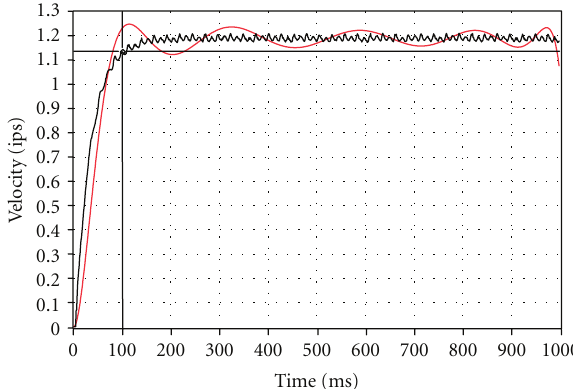
Figure 2: Approach w/o consideration of disturbance under 2volt input: black, measurement: red, power series fitted.